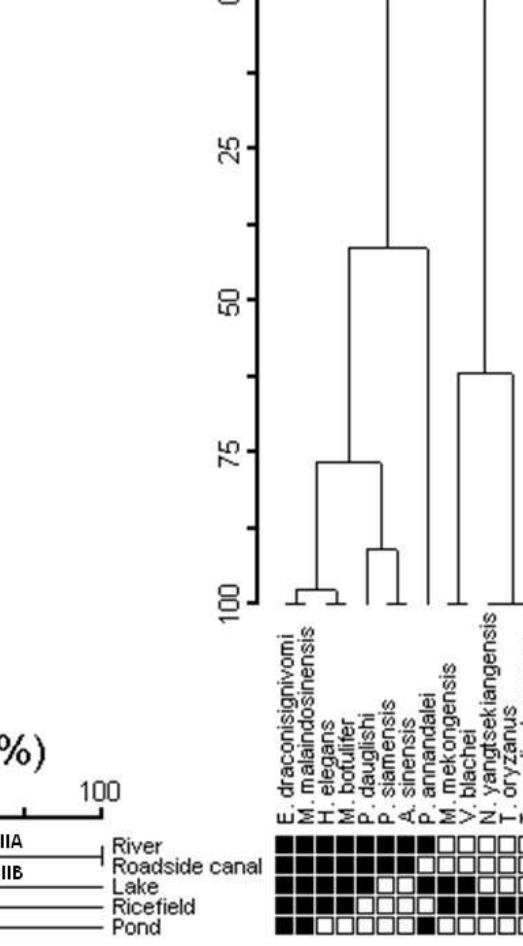
Figure 5. The similarity of the sites is based on the species present in each of the different habitats in southern Vietnam.